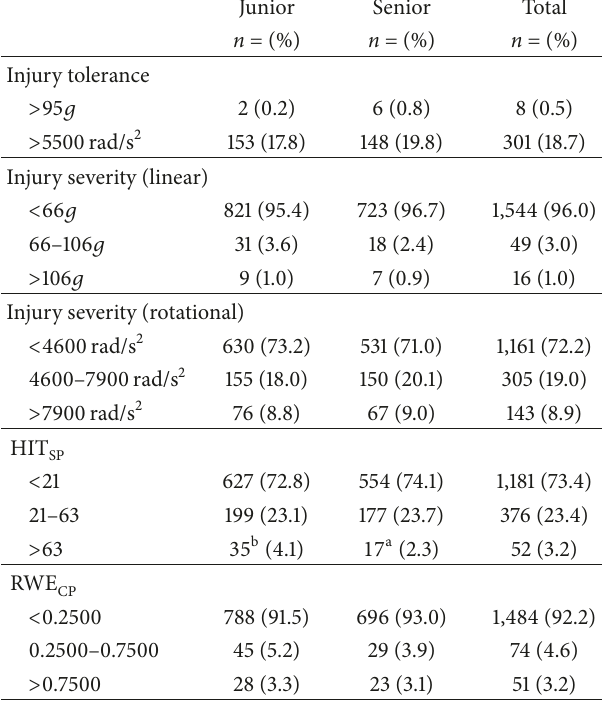
Table 3: Impacts to the head greater than 10 𝑔 by injury tolerance, injury severity for resultant linear and rotational accelerations, Head Impact Telemetry Severity Profile and Risk Weighted Exposure Combined Probability for total impacts, impacts recorded by junior, senior, and total in an amateur Australian Football League team over a season of